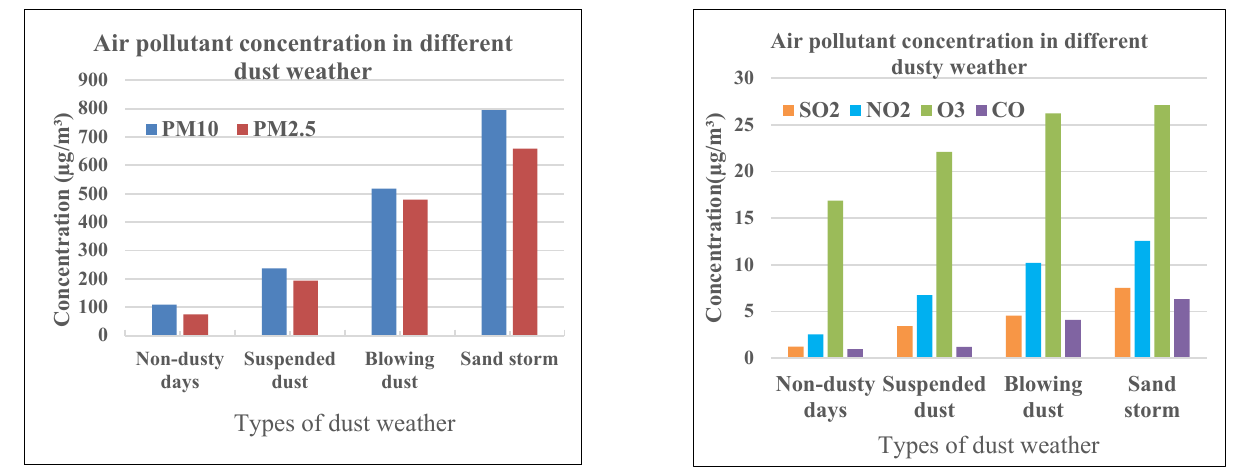
Figure 2. Air pollutant concentrations in different dust weather conditions.